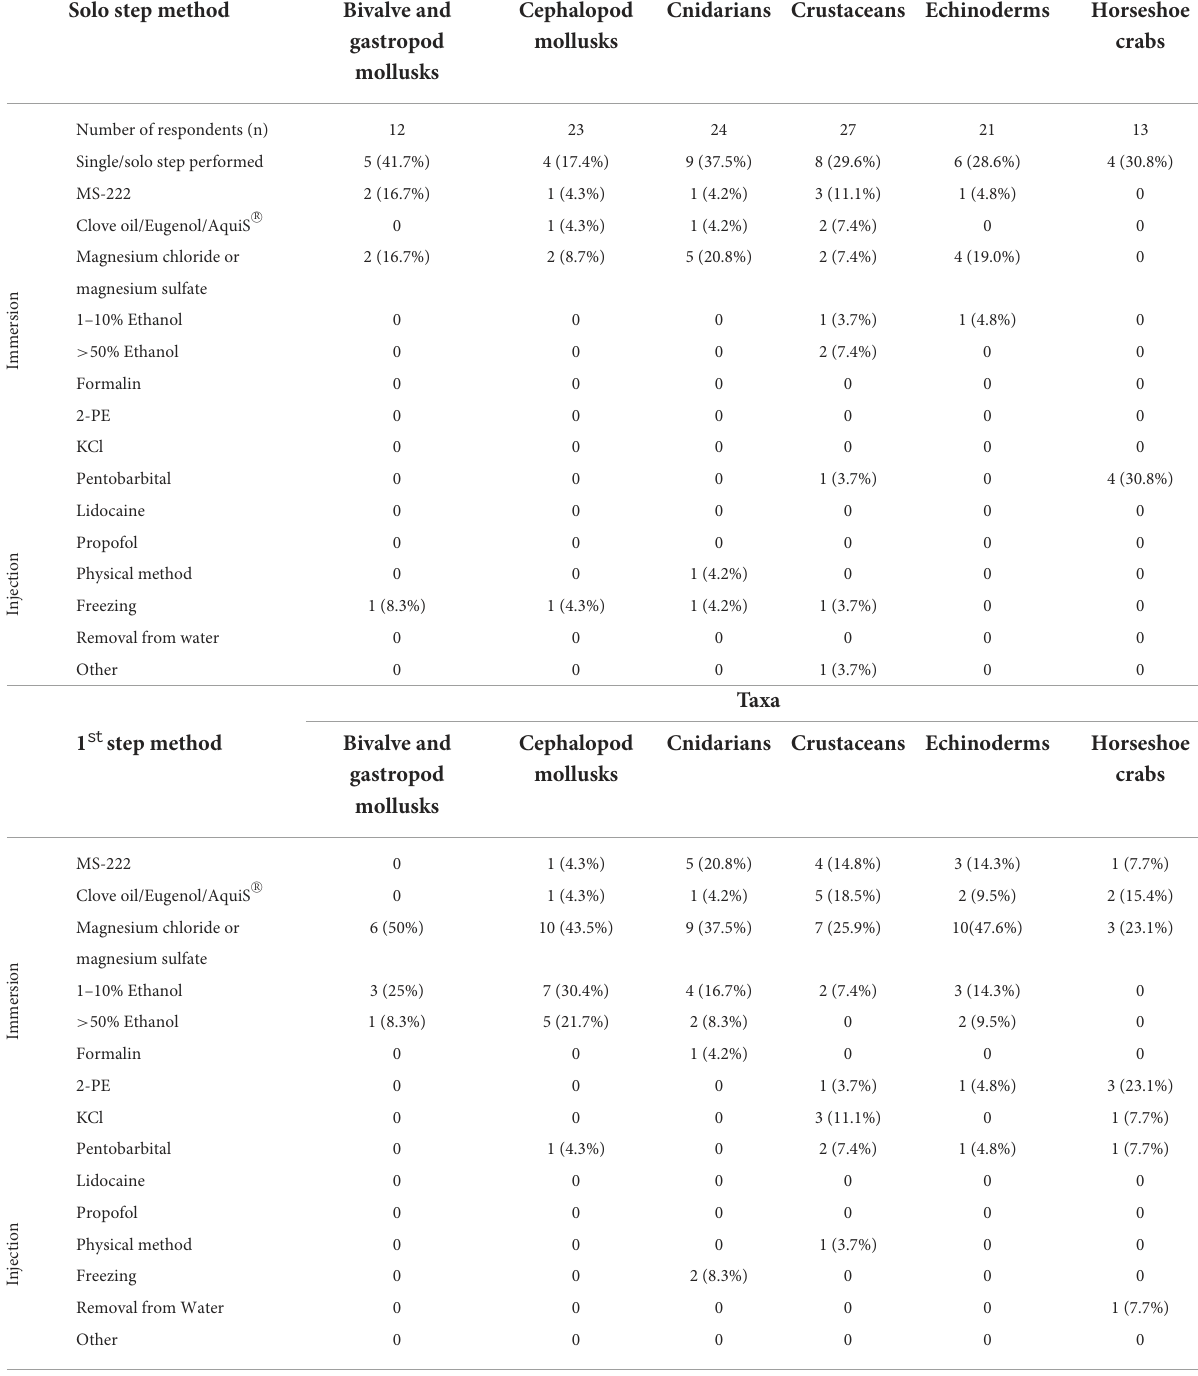
TABLE 1 Responses from an electronically delivered survey on currently used methods for euthanasia of aquatic